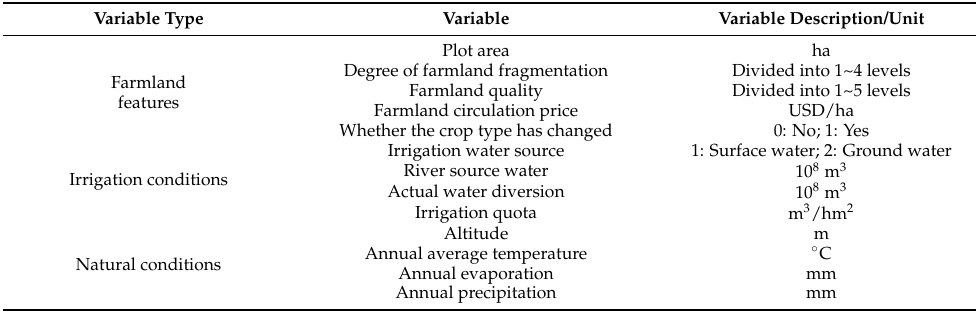
Table 3. Explanation and description of explanatory variables.